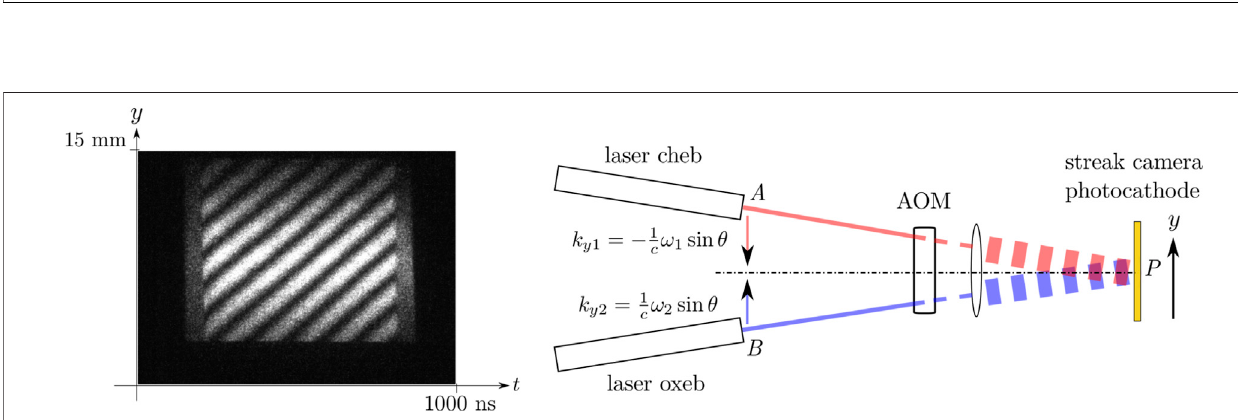
Frontiers in Physics |